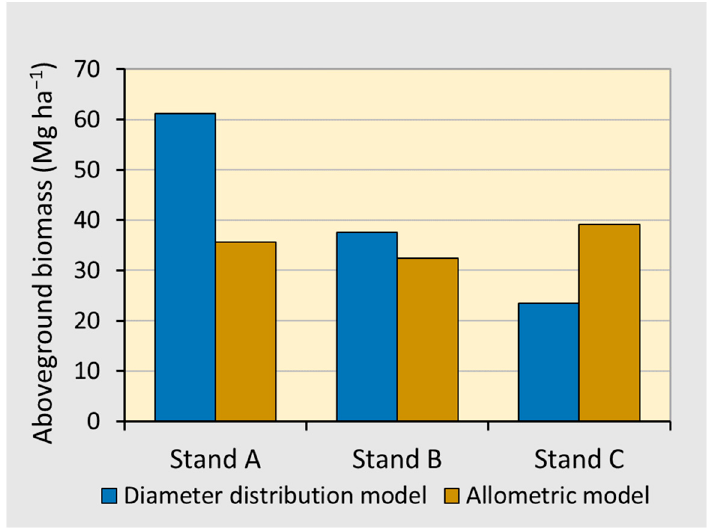
Figure 5. Comparison of aboveground biomass predicted by the diameter distribution model and allometric model with age factor for Ma bamboo stands.